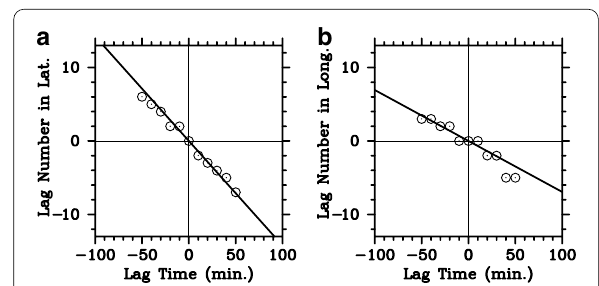
Fig. 3 a Latitudinal and b longitudinal lag numbers of the maximum ACF at each time epoch for the time lag from an interval of 10 min for the detrended TEC within the area of 133.0°–137.0° E and 33.0°–37.0° N between 14:00 and 16:00 UT on 8 June 2019. Solid line in each panel represents regression line of latitudinal (longitudinal) lag number with respect to the lag time of the maximum ACF, assuming that the regression line passes the origin. To obtain the regression line, inverse of lag number in latitude (longitude) was used as a weighting